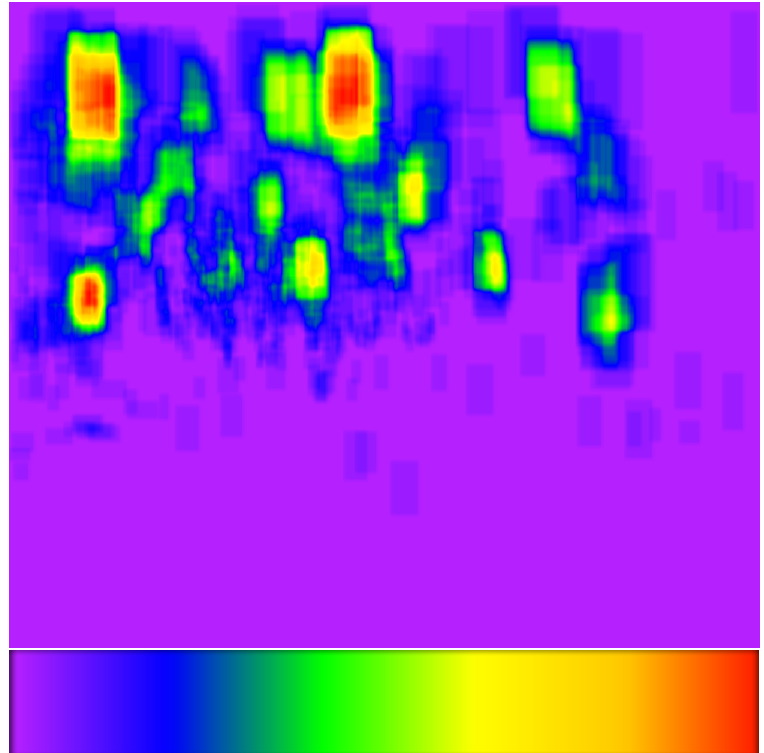
Figure 6. Frequency map of traffic light appearances in a sample of [2] dataset. Scale on the bottom.